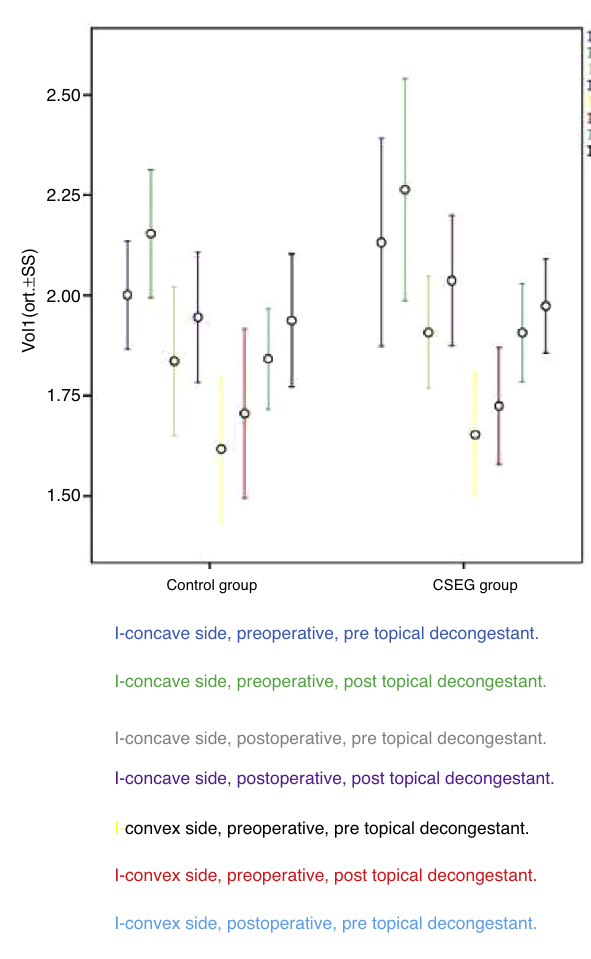
Average nasal cavity volume (VOL1) values of the study and control group. without any statistically significant difference between groups ( p = 0.432; Fig. 6).